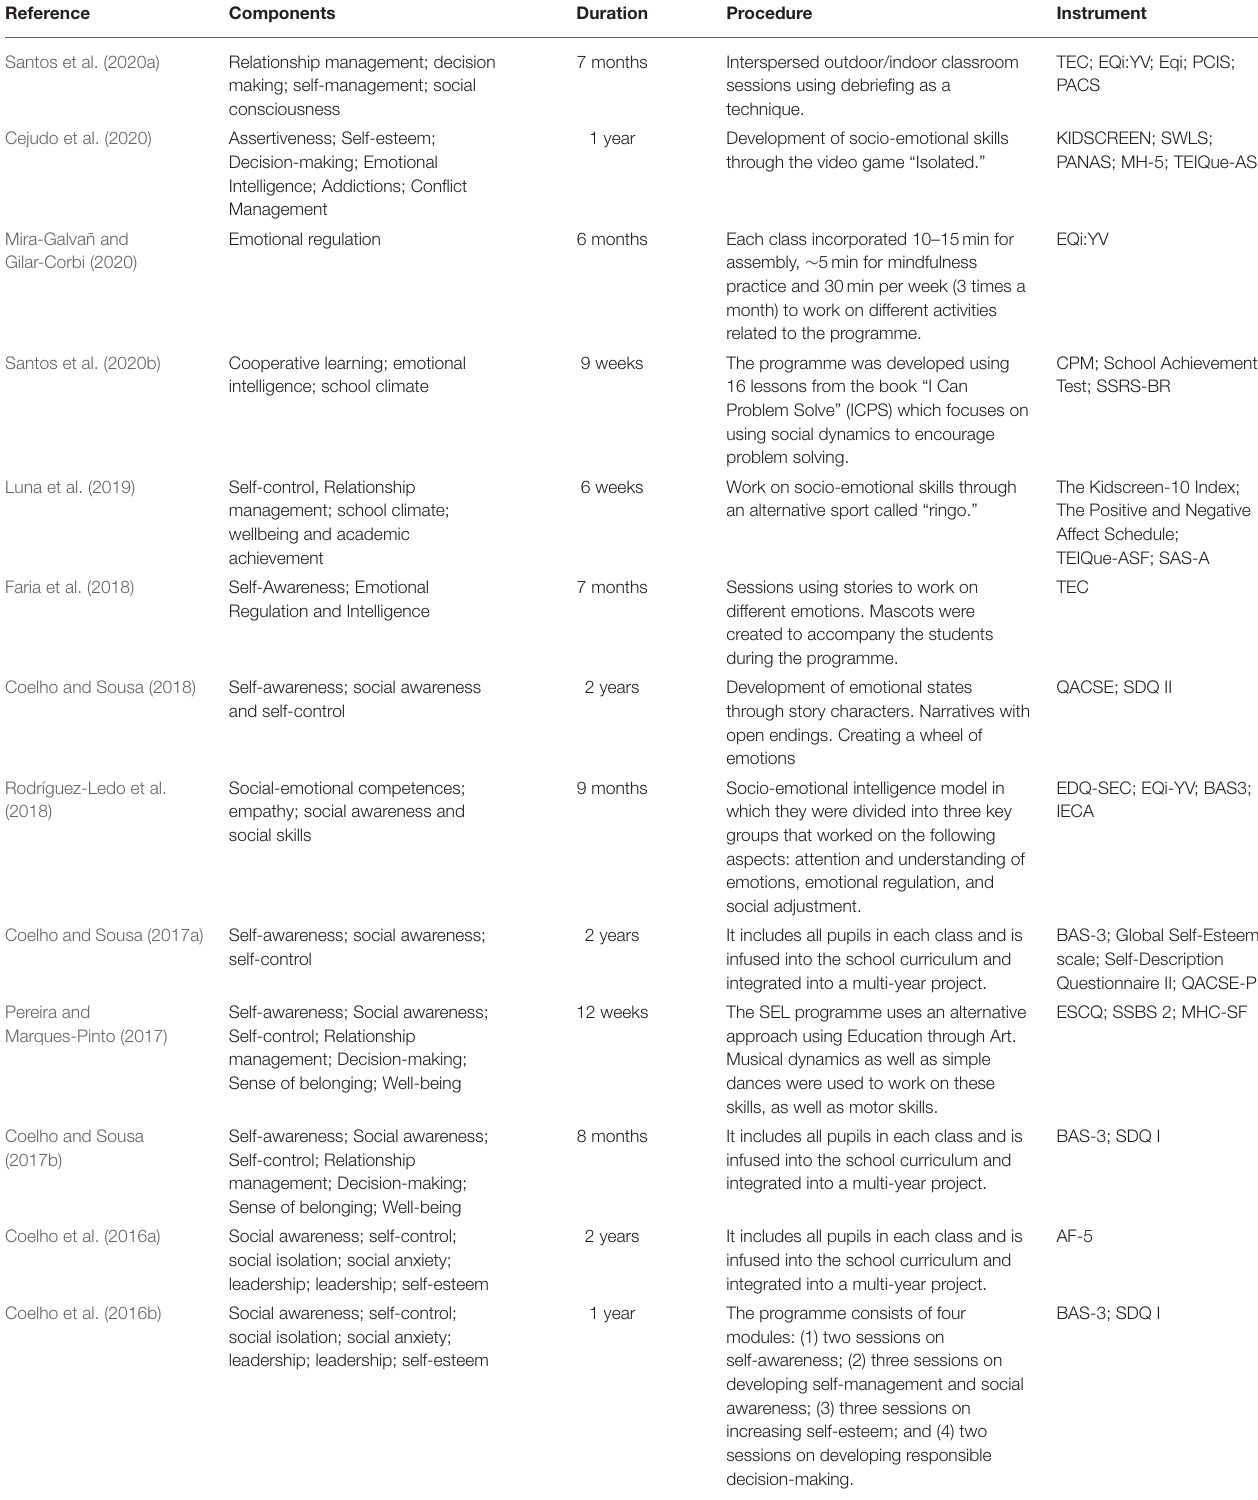
TABLE 1 | Most relevant characteristics of the SEL programmes